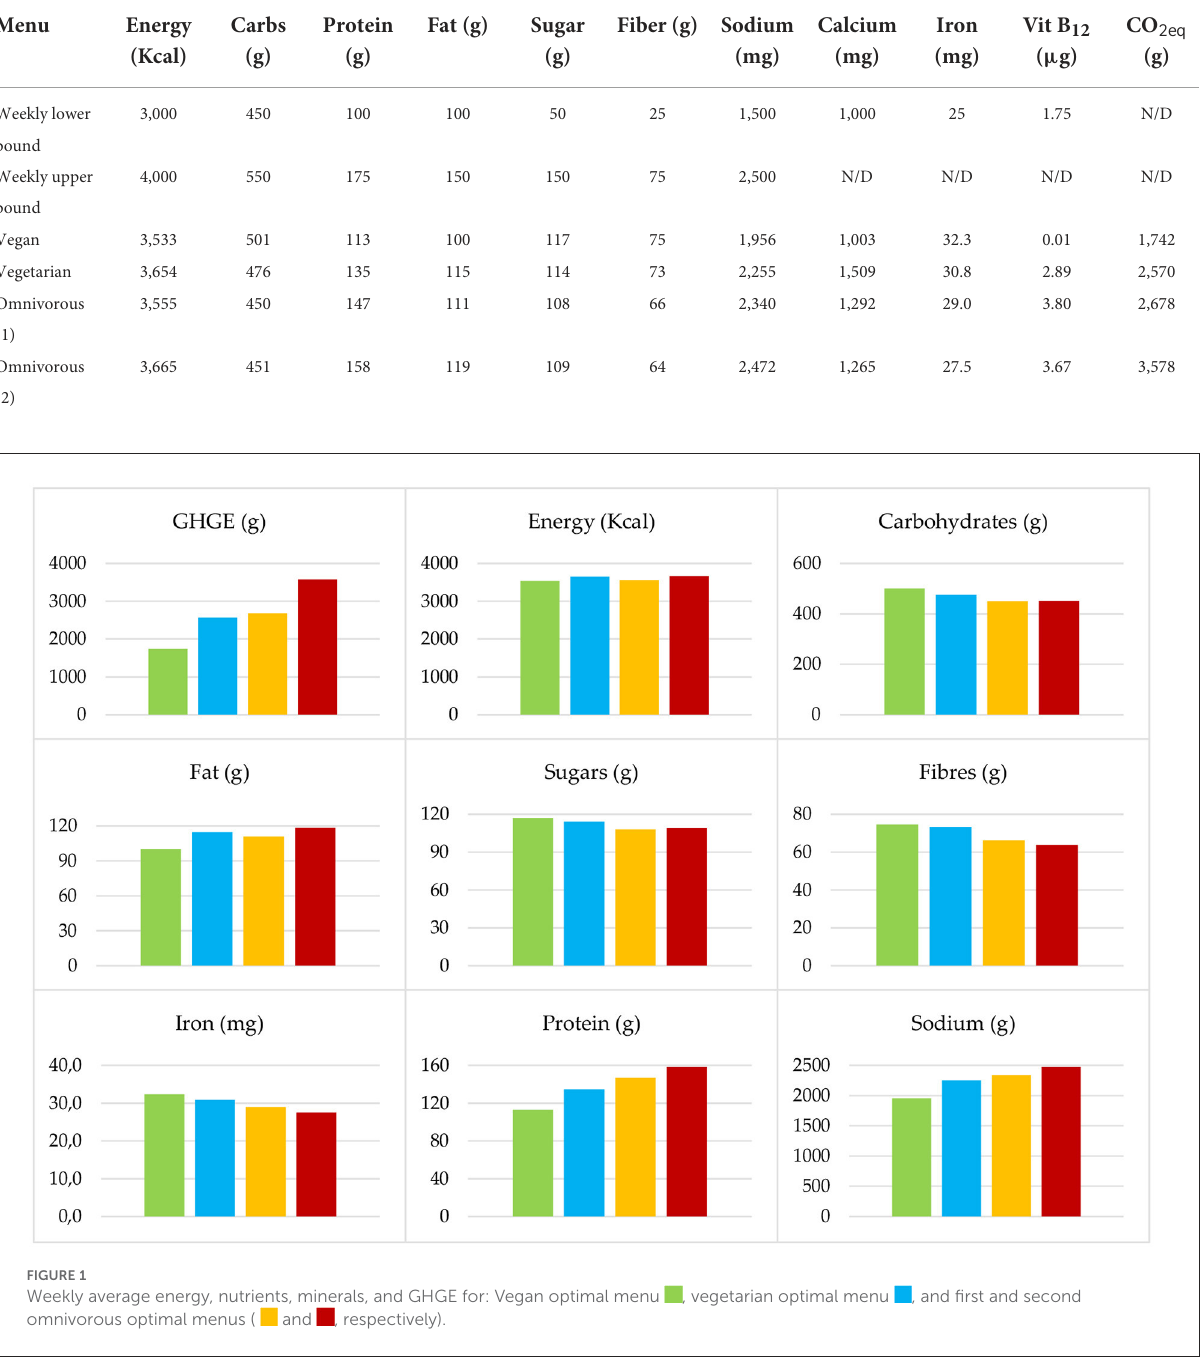
TABLE 3 Weekly average energy, nutrients, minerals, and GHGE for the four optimal menus considered.